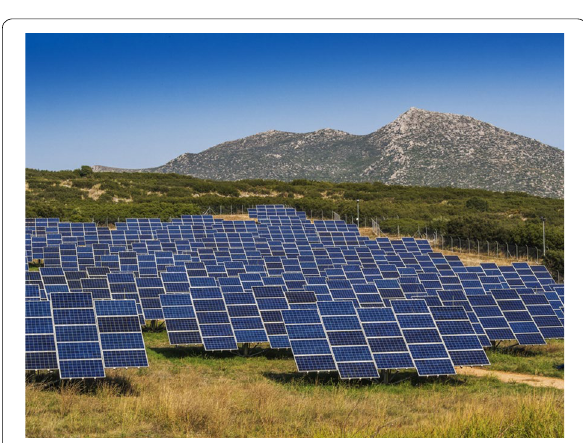
Fig. 24 Photovoltaic park in the countryside in Lombardy, IT (from www.vigil anzag roup.it)